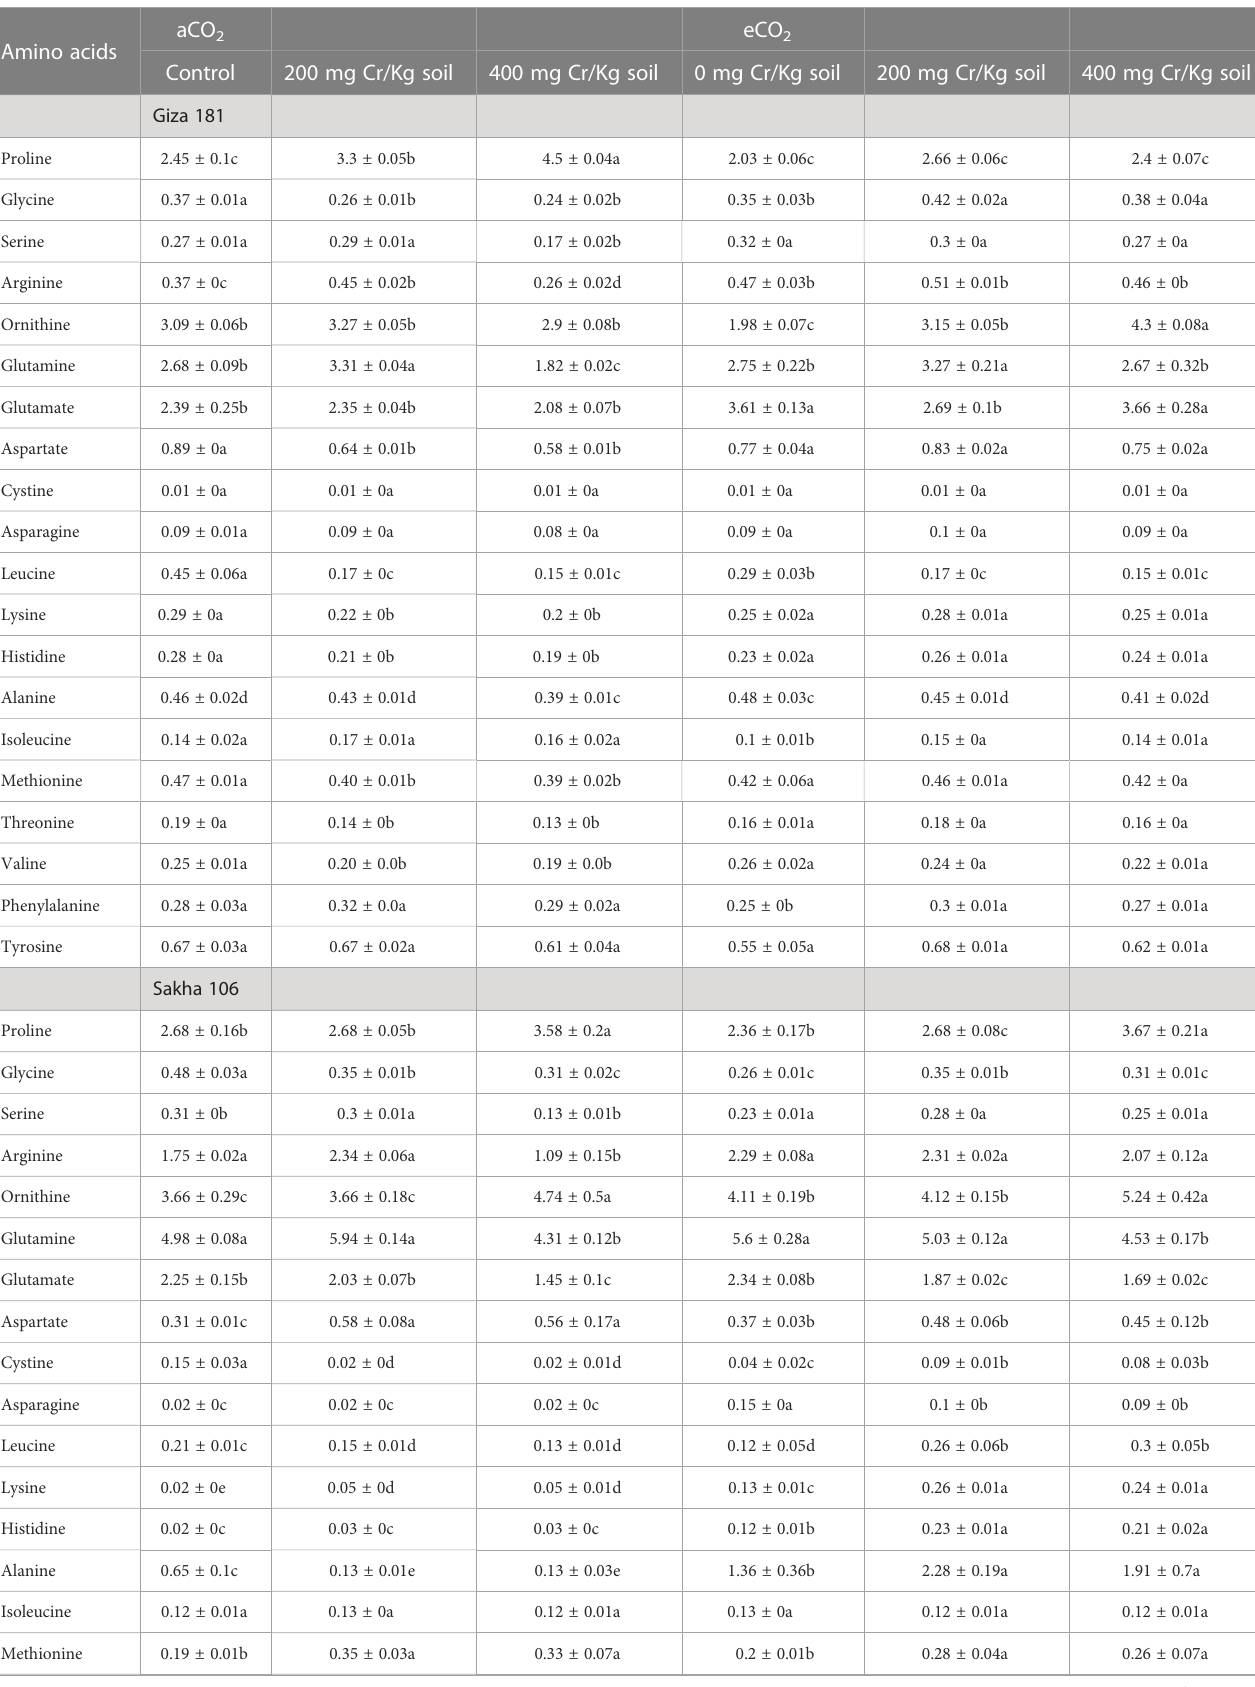
TABLE 3 Effect of Chromium (Cr) exposure on amino acids pro fi le of rice grains produced under either aCO 2 (410 ppm) or eCO 2 (620